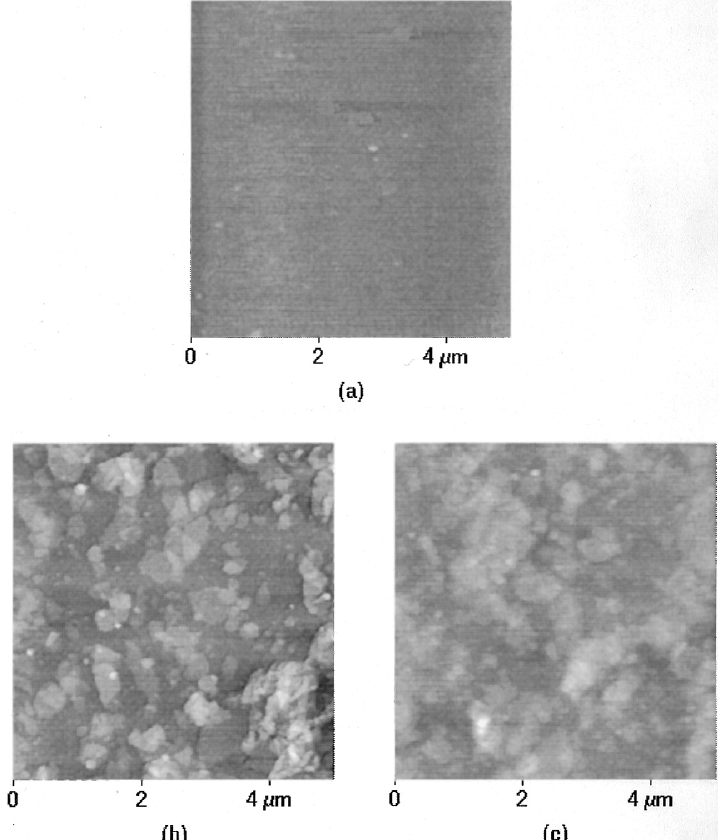
Figure 22. AFM images of ( a ) PDAC layer on a silicon wafer before PM adsorption; ( b ) one layer of PM adsorbed to the PDAC layer; and ( c ) two bilayers of PDAC/PM film. Reprinted with permission from reference [151]. Copyright 1998 American Chemical Society.